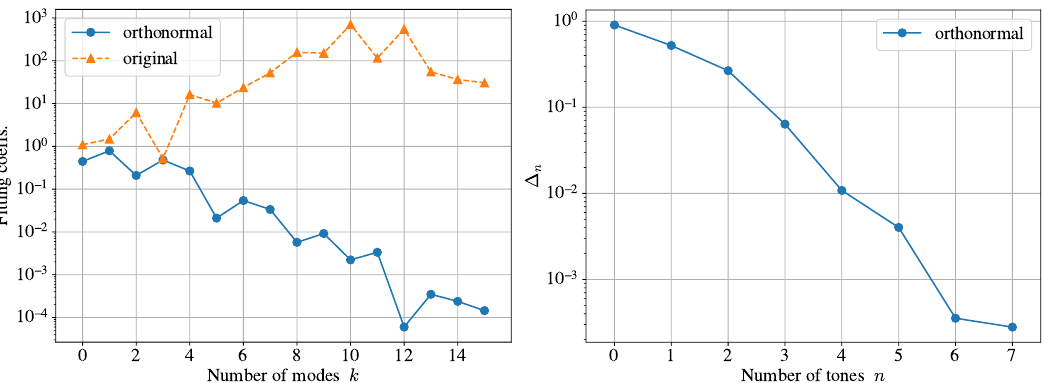
Figure 9. Fitting coefficients of the ( (cid:96) = 2, m = 2 ) spheroidal harmonic mode of SXS:BBH:0305. The ( left panel) displays the absolute values of the fitting coefficients for ˜ C (cid:96) m in the ( right column) show ∆ n in Equation